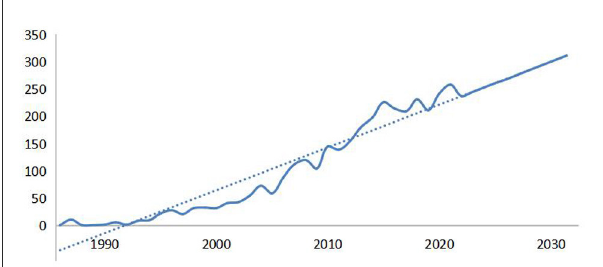
FIGURE1 Number and trend of annual publication on schizophrenia and oxidative stress by year.